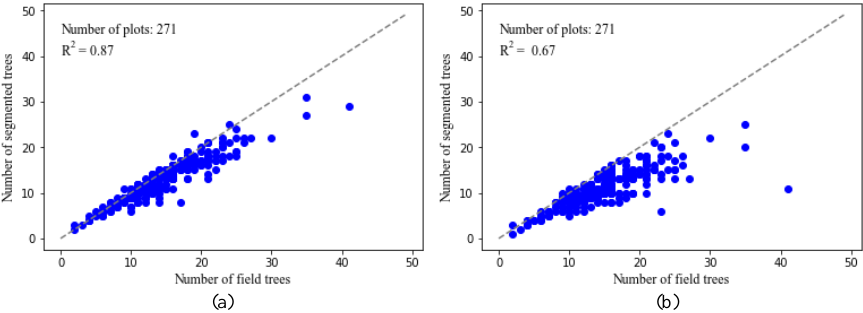
Figure 12. The relationship between the number of field trees and the number of segmented trees in the 271 plots. ( a ) Multi-threshold and ( b ) DSM-based.